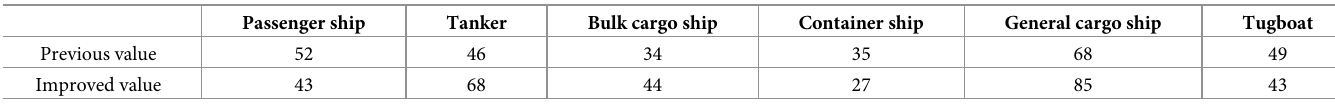
Table 2. The improved emission factor ratio of CO 2 to NO x .